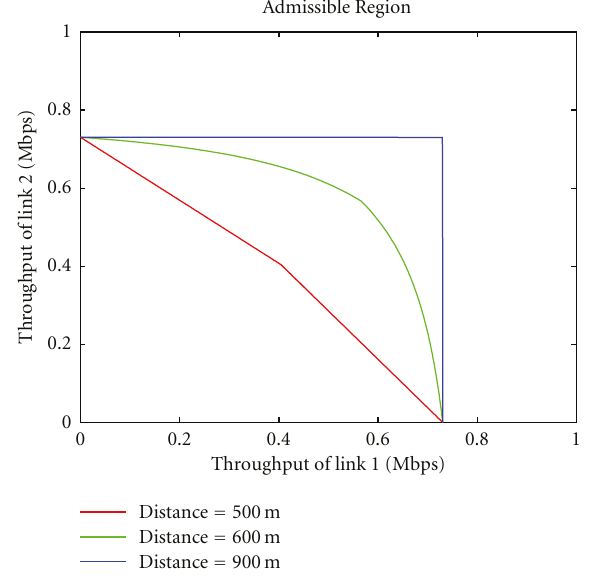
Figure 8: Admissible region for various link separations.